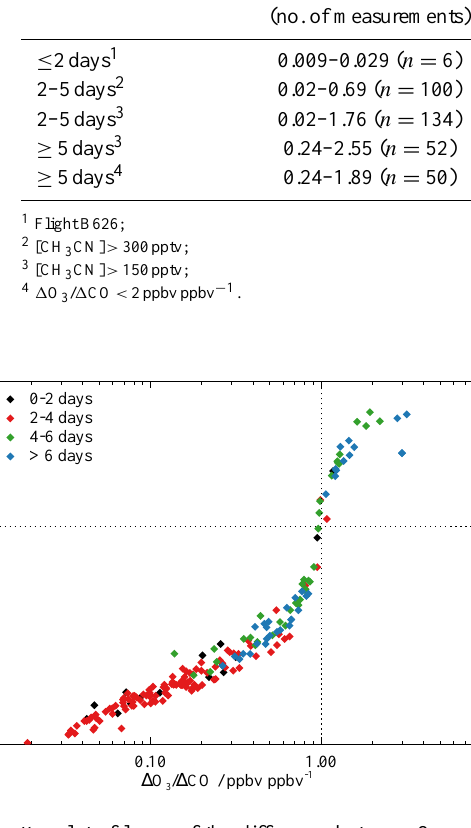
Fig. 7. Scatter plot of log 10 of the difference between O 3 and CO enhancements in biomass burning plumes relative to background values (i.e. 1 O 3 and 1 CO) as a function of the 1 O 3 / 1 CO en- hancement ratio. The data are filtered based on photochemical ages calculated from the ln(C 3 H 8 /C 2 H 6 ) ratio. The horizontal and ver- tical dotted lines show the zero difference and unit ratio values, re-